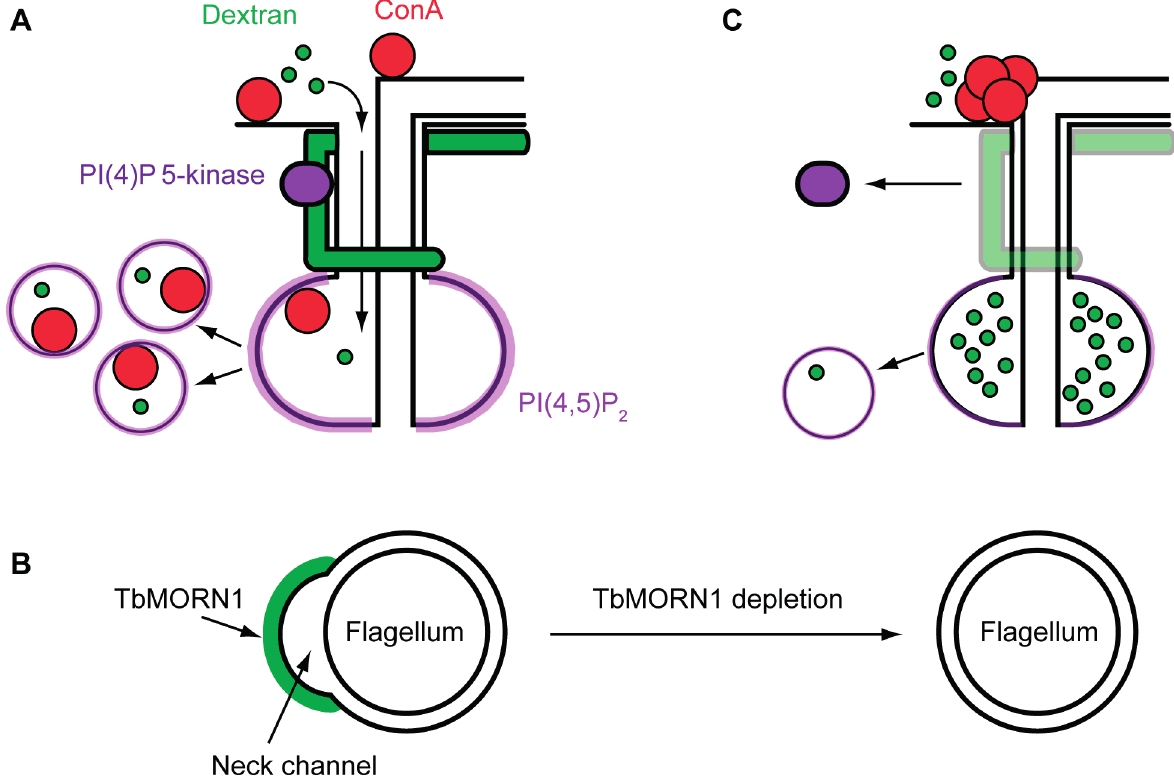
Figure 4. A hypothetical model for TbMORN1 function. ( A ) Schematic of possible function in wild-type cells. TbMORN1 (green) holds open the neck channel to facilitate macromolecule entry to the FP, and also acts as a scaffold for a PI(4)P 5-kinase. Material entering the FP is taken up in endocytic vesicles; ( B ) A transverse cross-section through the flagellar pocket neck. TbMORN1 molecules cluster on the cytoplasmic face of the membrane, causing it to bend inwards and create the neck channel. When TbMORN1 is depleted, the membrane is no longer bent outwards and the channel collapses; ( C ) The collapse of the neck channel inhibits the entry of large macromolecules such as ConA. Loss of TbMORN1 also impairs the localisation of the PI(4)P 5-kinase, resulting in a decrease in PI(4,5)P 2 synthesis. The lower levels of PI(4,5)P 2 on the FP compromise